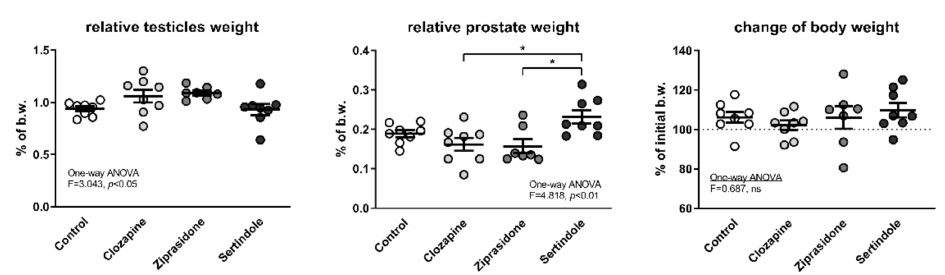
Figure 1. Relative testicle and prostate weight at the end of the experiment together with the change in body weight during the four-week treatment with APDs. Mean values and standard errors are presented; b.w.—body weight; *— p <